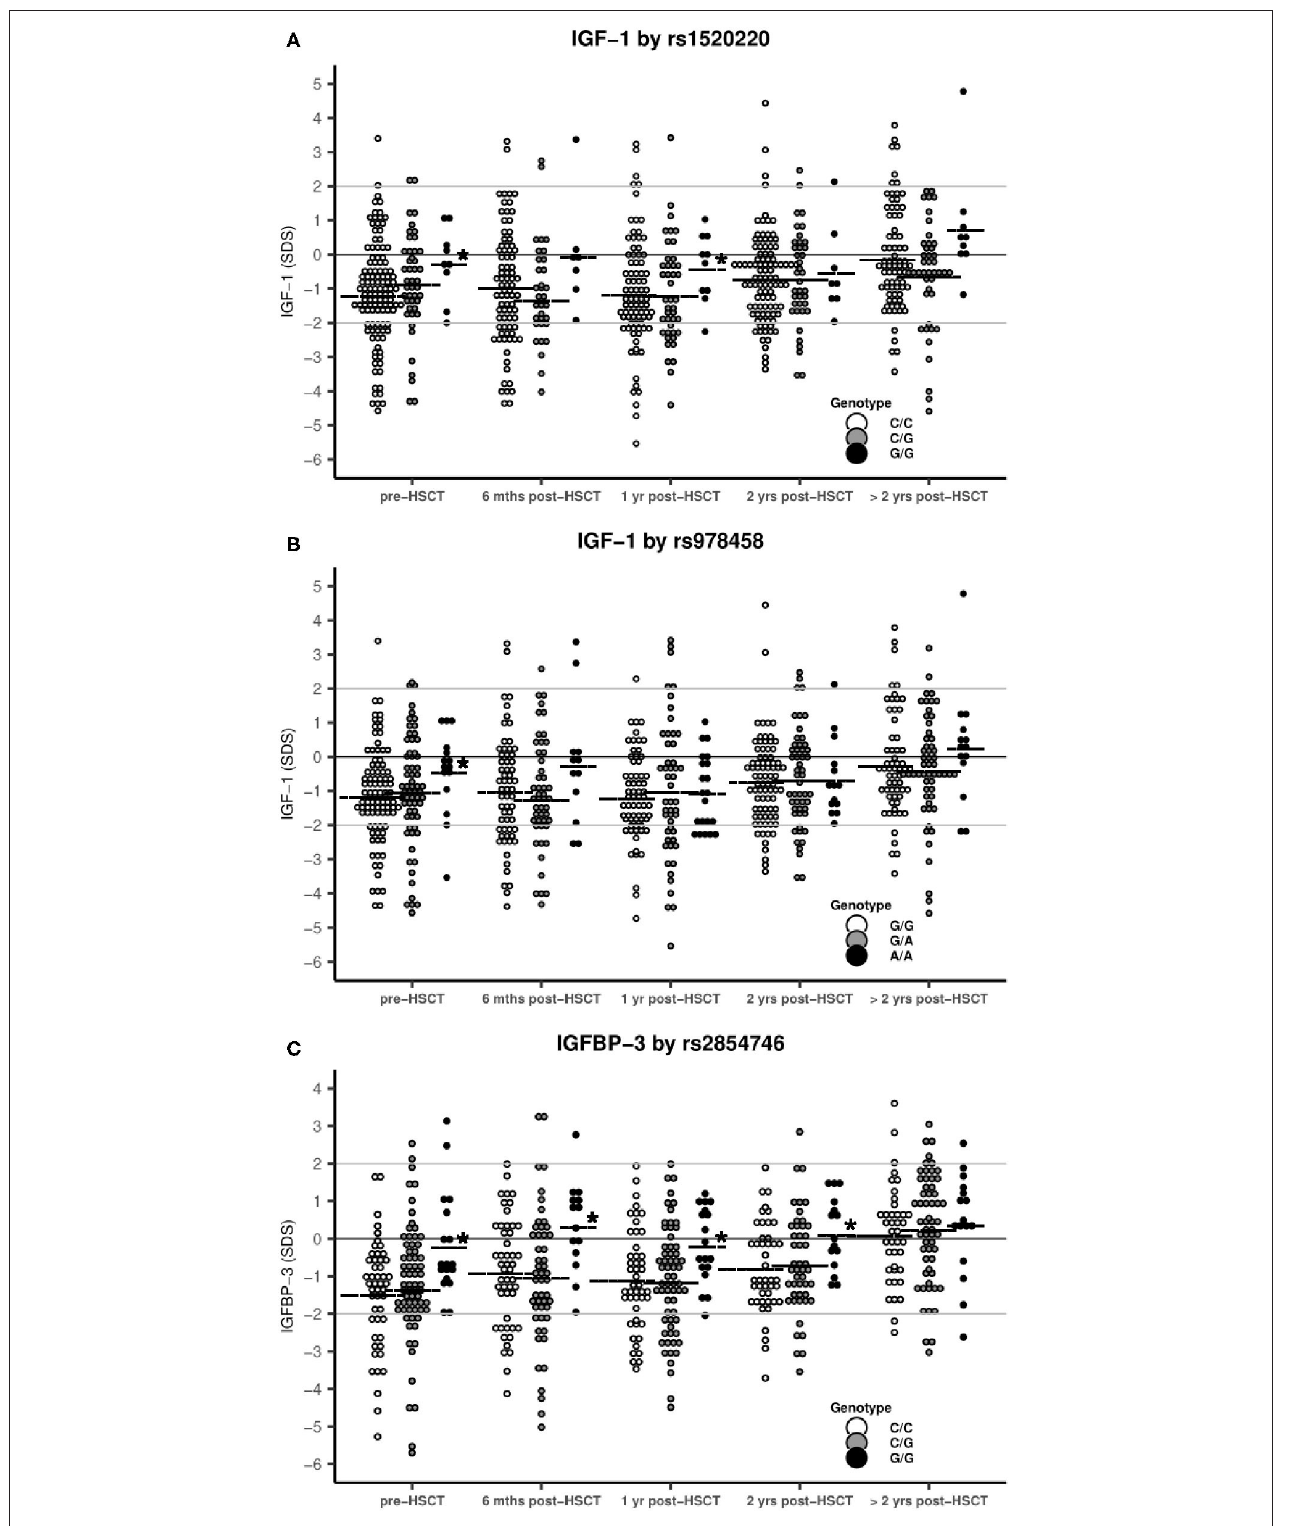
FIGURE 2 | IGF-1 and IGFBP-3 levels stratified by SNP genotypes. Horizontal line: mean IGF-1/IGFBP-3 SDS. *statistical difference between genotypes. (A) rs1520220: Mean IGF-1 levels were significantly higher in patients with the G/G genotype pre-HSCT ( P = 0.002) and at 1 year post-HSCT ( P = 0.05) compared